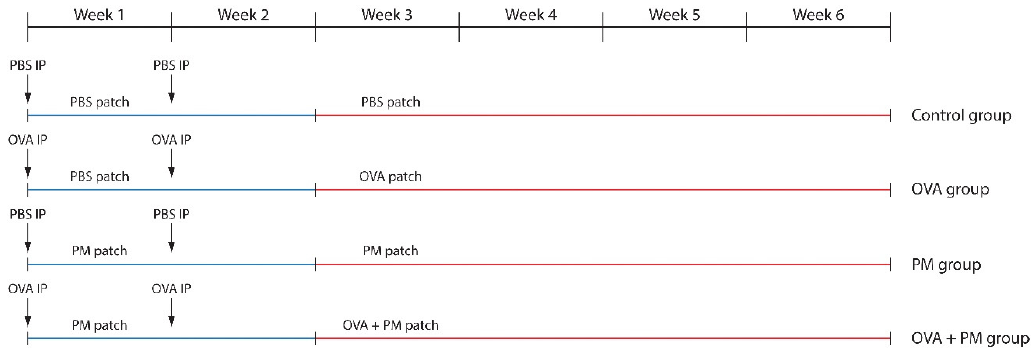
Figure 9. Experimental protocol for assessing the effects of OVA (IP + cutaneous) and PM 10 (cutaneous) exposure in BALB/c